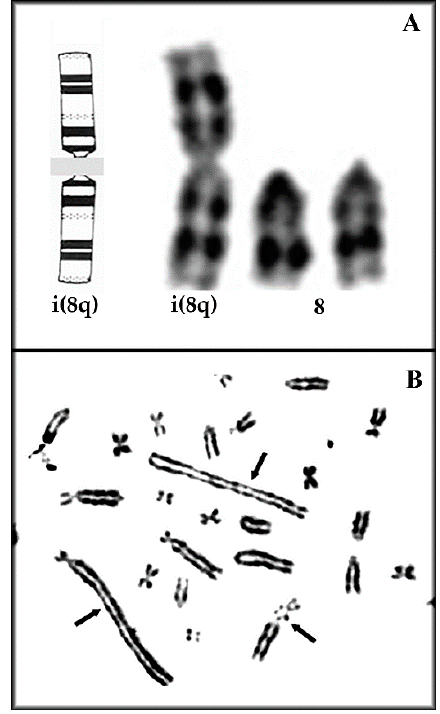
Figure 4. Representative clonal chromosome aberrations seen in A ‐ FC6. ( A ) Ideogram reconstruction and isochromosome #8 seen in 100% of metaphases, ( B ) dicentric and triradial chromosomes (arrows).